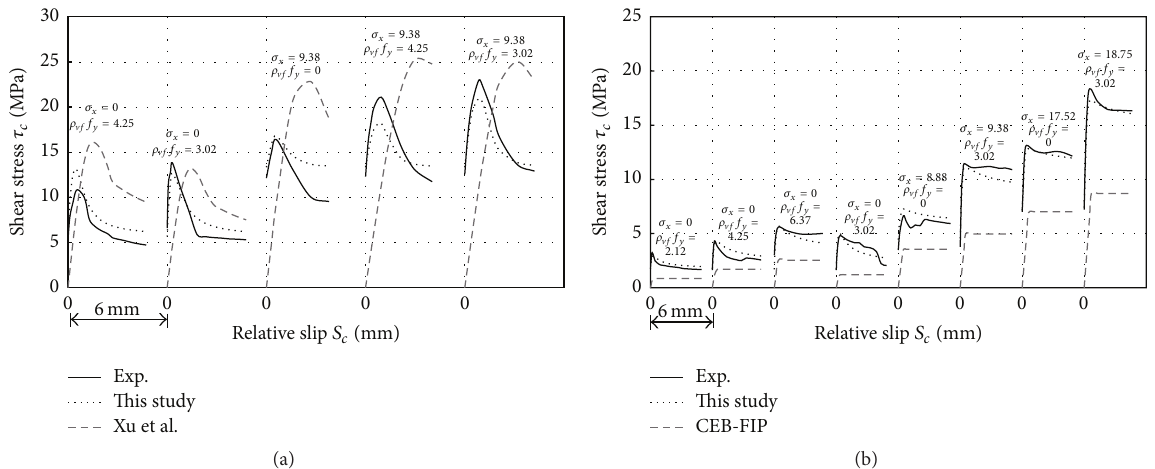
Figure 5: Typical comparisons of predicted shear stress-relative slip curves with experimental results: (a) push-off specimens with monolithic joints; (b) push-off specimens with smooth construction joints.